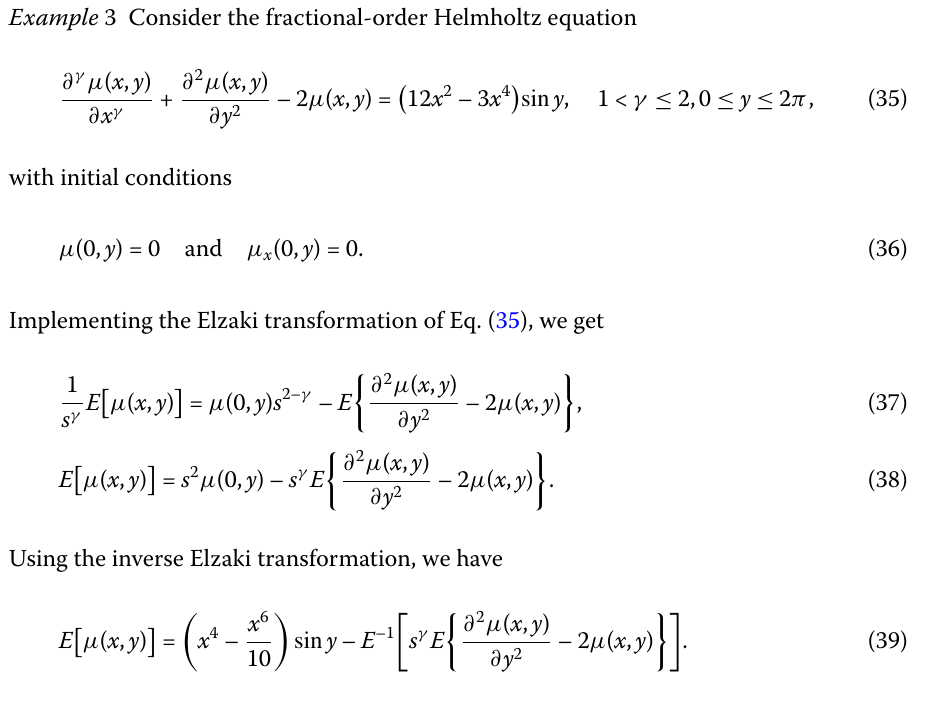
an integer-order result of the problem. In the same way, we can draw the graphs for the y -space fractional-order